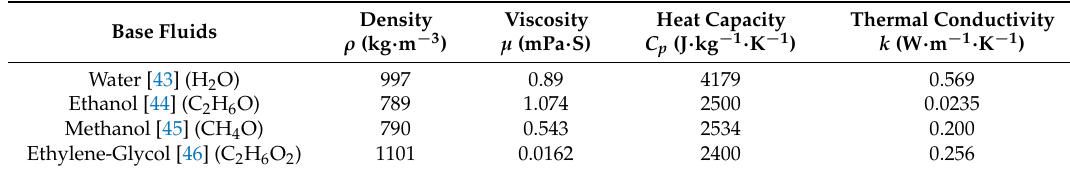
Table 1. Thermo-physical properties of the base fluids.